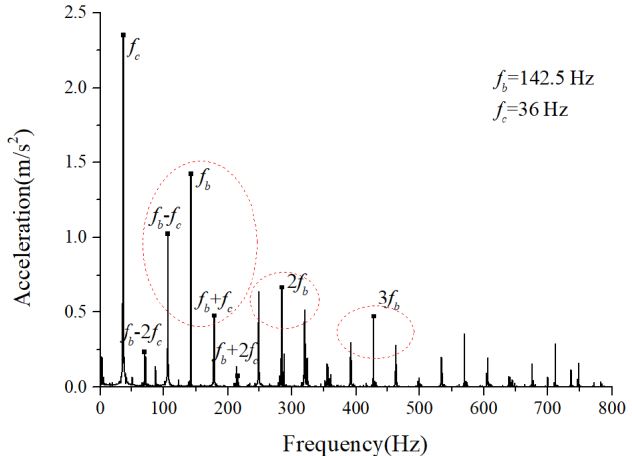
Figure 11. Acceleration envelope spectrum.